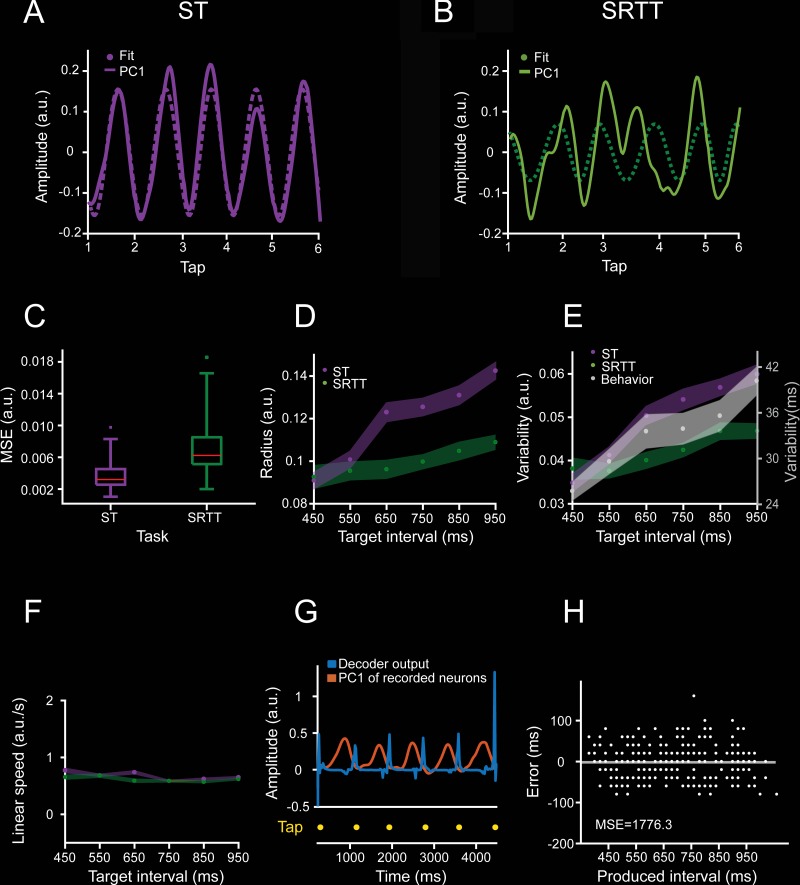
Comparison of ST and SRTT trajectories in simultaneously recorded neurons.A. Neural activity data projected on the PC1 (solid line, linearly detrended) and the correspondent sinusoidal fit (dotted line) during a trial of ST for the target interval of 650 ms. B. Similar to (A) for SRTT. Note that the strong periodic structure of the ST neural trajectory is lost during SRTT for the same population of cells. C. The MSE of the sinusoidal fits during ST (purple) is significantly smaller than during SRTT (green; 60 trials, two-sample t test = −6.78, p < 0.0001). D. Radii of the neural trajectories during ST (purple, slope = 0.000087, constant = 0.055, R2 = 0.619, p < 0.0001) and SRTT (green, nonsignificant linear regression, R2 = 0.0172 and p = 0.489) as a function of target interval. E. Variability of the neural trajectories during ST (purple, data slope = 0.000037, constant = 0.028, R2 = 0.368, p < 0.0001), SRTT (green, nonsignificant linear regression, R2 = 0.0005 and p = 0.903), and temporal variability of the monkeys’ produced intervals (gray, mean ± SD/2, data slope = 0.0009, constant = −0.003, R2 = 0.999, p < 0.0001) across target intervals during ST. F. Linear speed of neural trajectories during ST (purple, mean ± SD, slope = 0.0001, constant = 7.322, R2 = 0.0007, p = 0.896) and SRTT (green, mean ± SD, slope = 0.002, constant = 4.049, R2 = 0.354, p = 0.002) did not change as a function of target interval. G. Output of the time-delay neural network (TDNN, in blue) trained to decode the duration of produced intervals based on the PC1 neural trajectories (orange) during a target interval of 850 ms. Tapping times are shown in yellow. H. TDNN error, defined as the difference between the produced and the decoded interval, as a function of produced interval. TDNN predicted accurately the performance of the monkey on a trial-by-trial basis (the decoded mean was not statistically different from 0, t test = −0.5228, p = 0.6). Underlying data are available in https://doid.gin.g-node.org/d315b3db0cee15869b3d9ed164f88cfa/. a.u., arbitrary unit; MSE, mean square error; PC, principal component; SRTT, serial reaction time task; ST, synchronization task; TDNN, time-delay neural network.